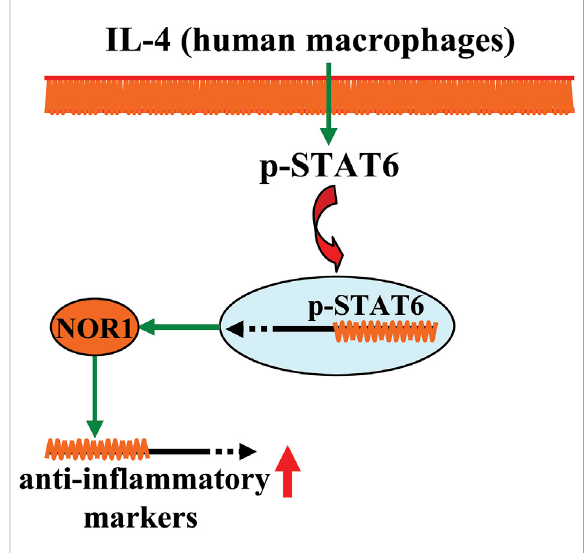
FIGURE 3 A schematic showing the regulatory effect of NOR1 in regulating in fl ammation in macrophages. In human macrophages, NOR1 appears to mediate the production of anti-in fl ammatory factors triggered by IL-4, which may contribute to the resolution of in fl